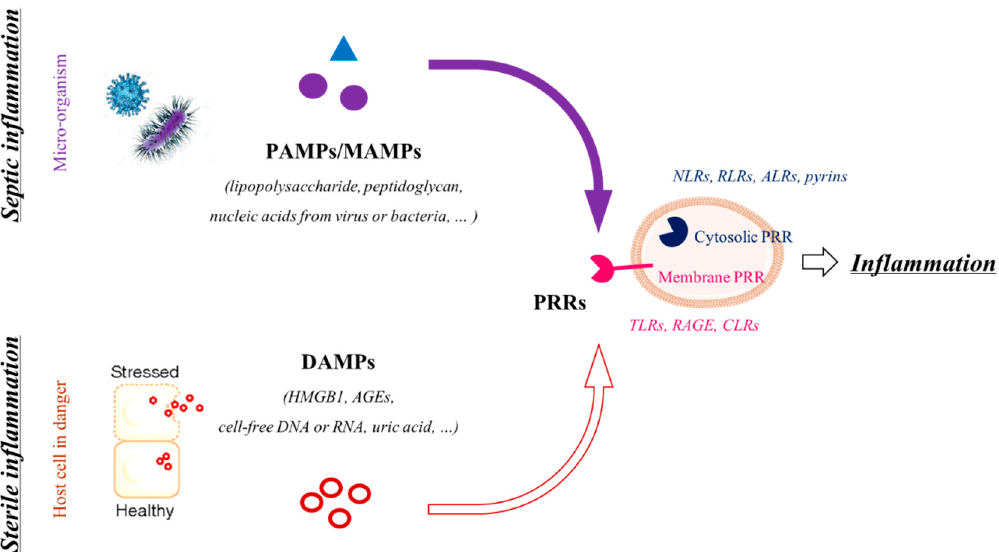
Figure 2. Two types of inflammation. This figure distinguishes the two types of inflammation: (i) the septic one implies the recognition of PAMPs/MAMPs derived from micro-organisms (viruses, bacteria or fungi); (ii) the sterile one is triggered by the recognition of DAMPs by the members of both PRRs (cytosolic or membrane-addressed). Both the recognition of PAMPs/MAMPs and DAMPs lead to a pro-inflammatory response.